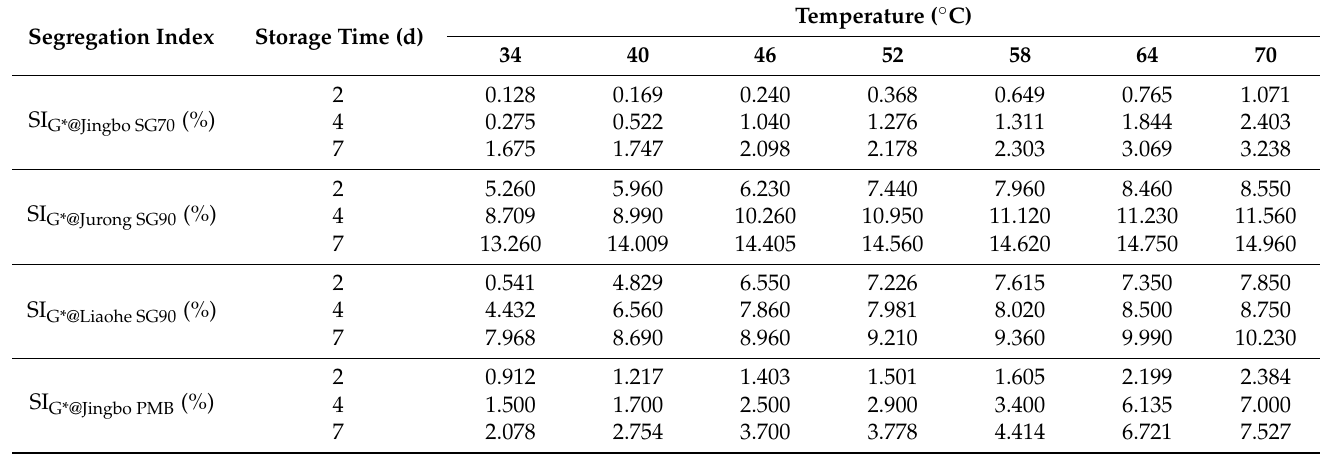
Table 4. Complex modulus segregation indexes of various bitumen binders at different storage times.